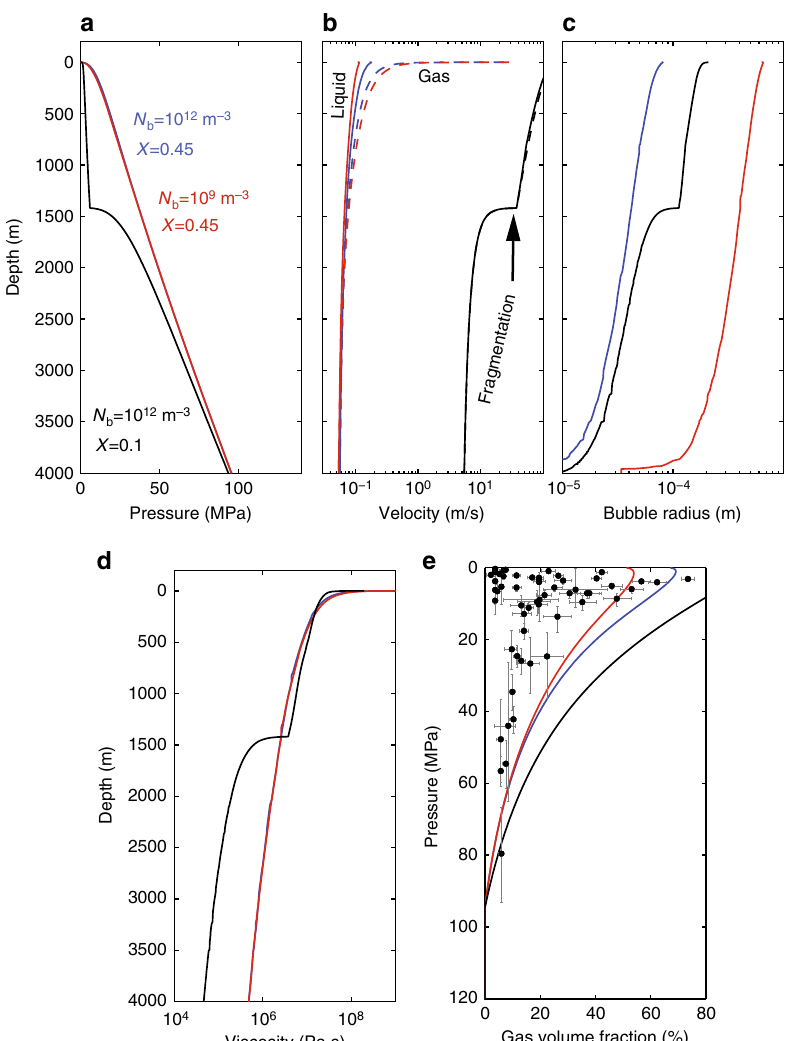
Fig. 6 Comparing the properties during ascent of hydrous leucogranite with different bubble number densities (N b ) and crystal contents (X). The model simulates magma ascent and gas escape, computed using the steady one-dimensional model of Degruyter et al 83 ., showing how a pressure, b melt (solid curves) and gas (dashed curves) velocities, c bubble radius and d magma viscosity evolve during ascent; e shows how vesicularity varies with pressure. Also, included vesicularity and the inferred pre-eruptive depth of clasts evacuated from the conduit during the 1997 Vulcanian eruptions at Soufrière Hills Volcano, Montserrat 223,224 . These samples are thought to capture conditions during ascent for the dome-forming eruptions 224 . Errors bars from Burgisser et al. 224 account for uncertainty in measured water content (pressure) and vesicularity. Note that the volume fraction of exsolved gas in the clasts is lower than expected when gas is allowed to escape from the rising magma. The effect of crystal fraction on viscosity is based on the model of Costa 178 and the melt viscosity model is that of Hess and Dingwell 177 . Fragmentation occurs at a gas volume fraction of 85%. In the model, crystals do not grow, and N b does not change during ascent. Homogeneous bubble nucleation and equilibrium degassing are assumed. Volatile content at depth is 4 weight %. Temperature is 886 °C. The percolation threshold for gas fl ow through the magma is zero, tortuosity factor is 3, bubble throat to radius ratio is 1, and the friction coef fi cient for gas fl ow through the magma is 10, values as used in Degruyter et al.